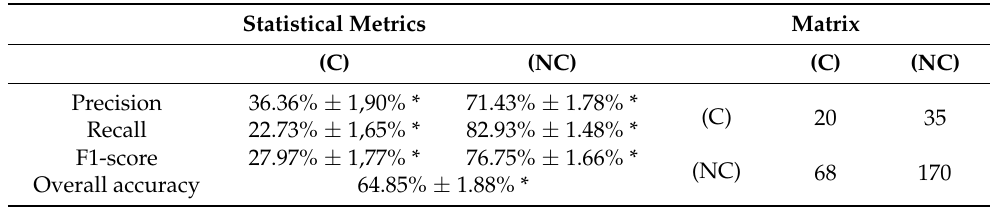
Table 3. Validation with p -value ≤